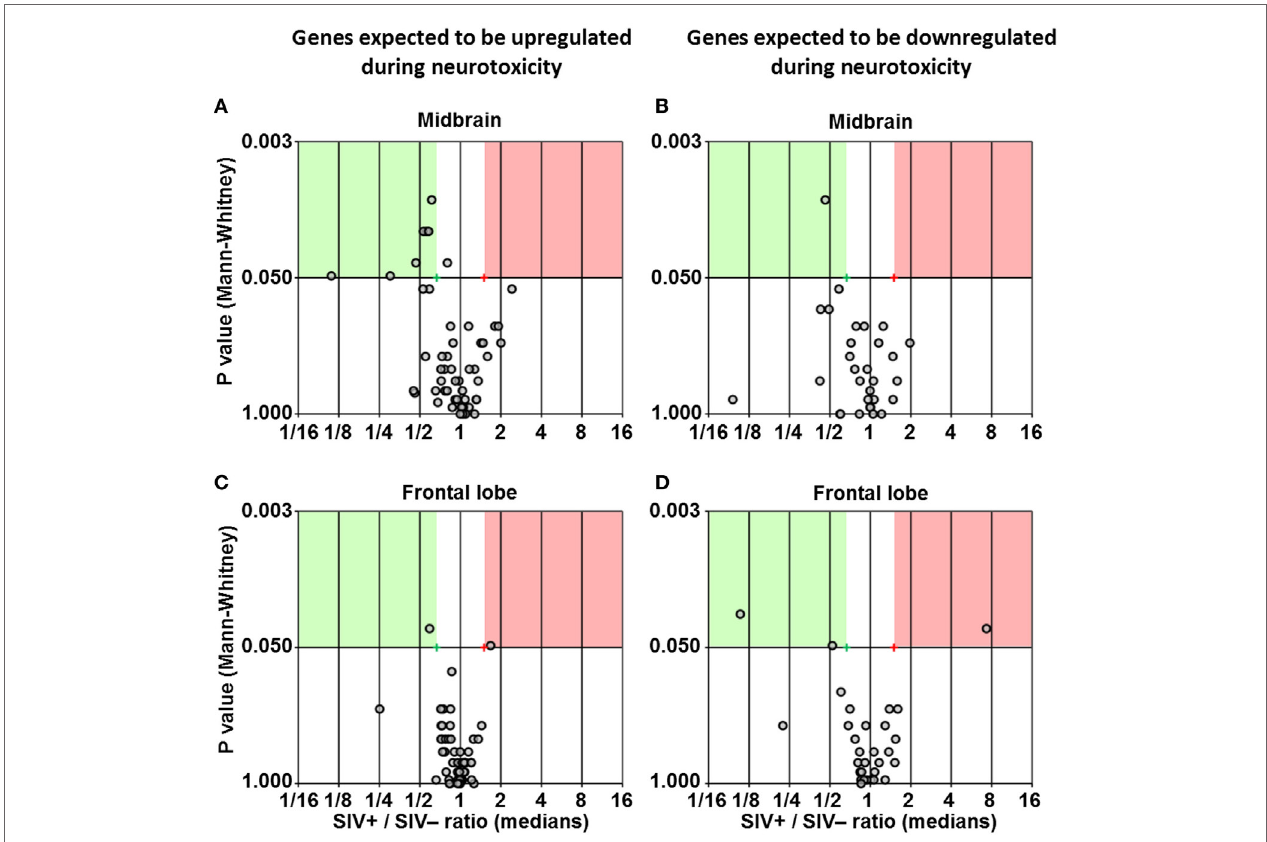
FigUre 5 | Differential expression of neurotoxicity genes . Volcano plots showing the ratio between median gene expression in simian immunodeficiency virus (SIV)-infected macaques and -uninfected macaques ( x axis; Log 2 scale), in relation to the P value (Mann–Whitney test; y axis; Log 20 scale), for midbrain (a,B) and frontal lobe (c,D) ; each dot represents one gene. Panels (a,c) show genes that are expected to be upregulated in neurotoxicity according to the array’s guidelines provided by the manufacturer, whereas panels (B,D) show genes that are expected to be downregulated in neurotoxicity according to the same guidelines (see Table S2 in Supplementary Material for details). Red and green areas highlight genes upregulated or downregulated in SIV-infected compared to -uninfected animals (1.5-fold; P <